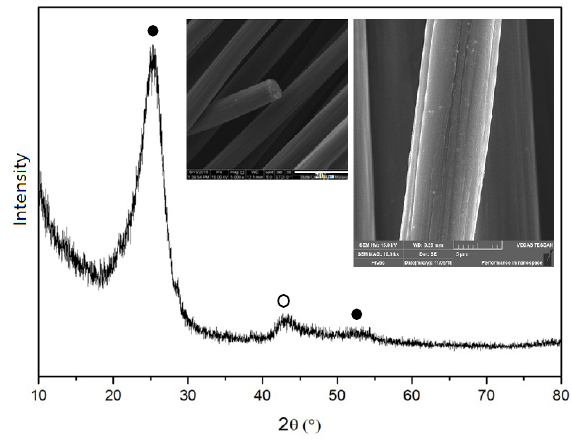
/C along with its SEM images 2 overlap with 2